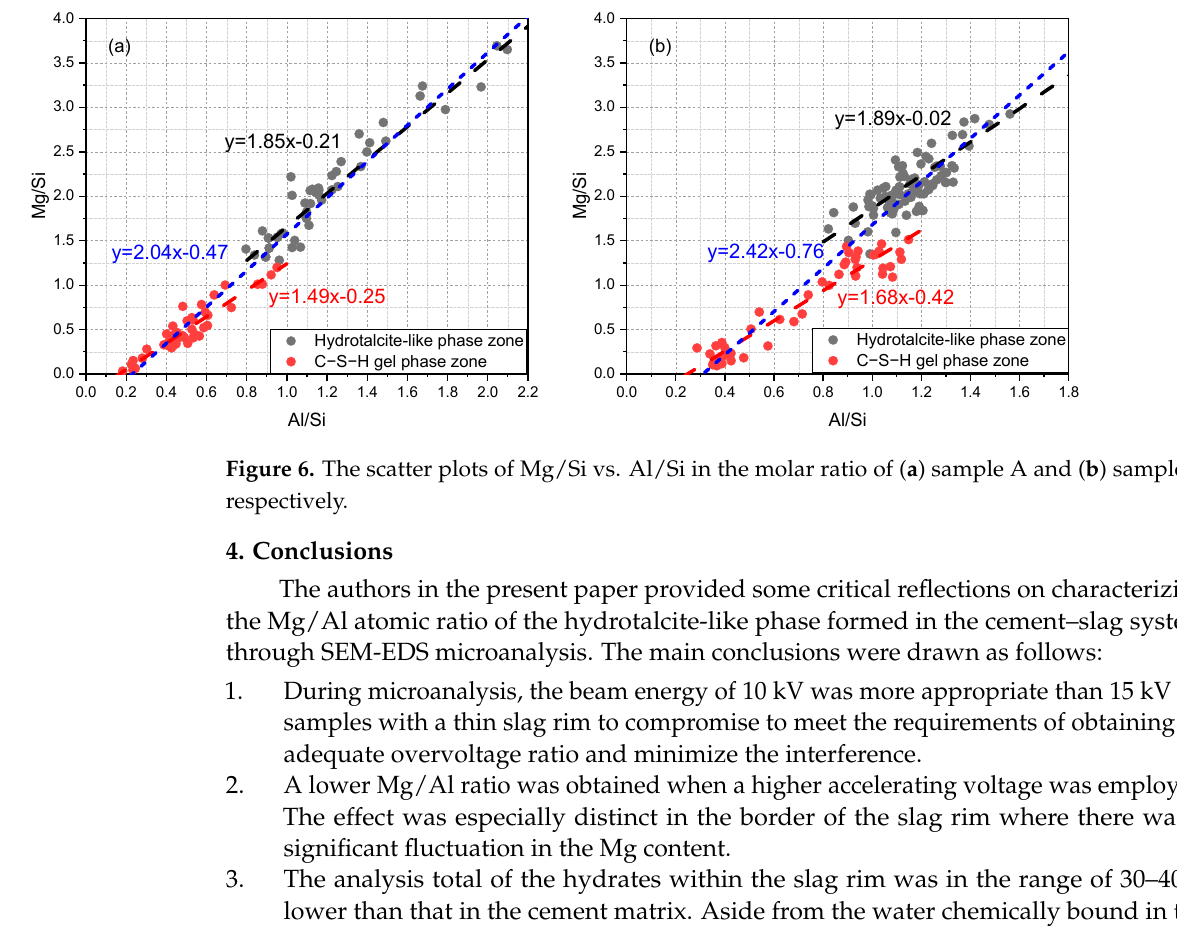
Figure 5. Some typical scatter points extracted from the point analysis of sample B, with elemental compositions exhibited in the table below.